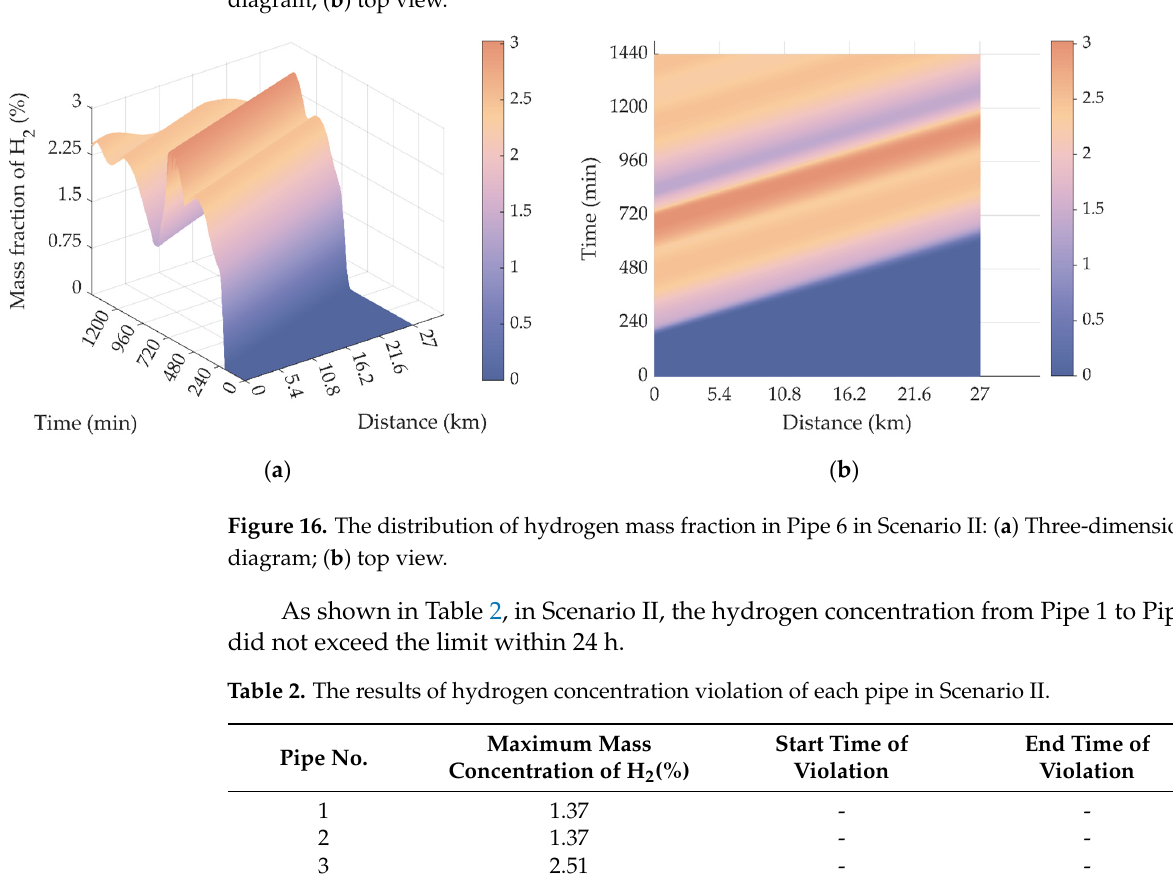
Figure 15. The distribution of hydrogen mass fraction in Pipe 4 in Scenario II: ( a ) Three-dimensional diagram; ( b ) top view.